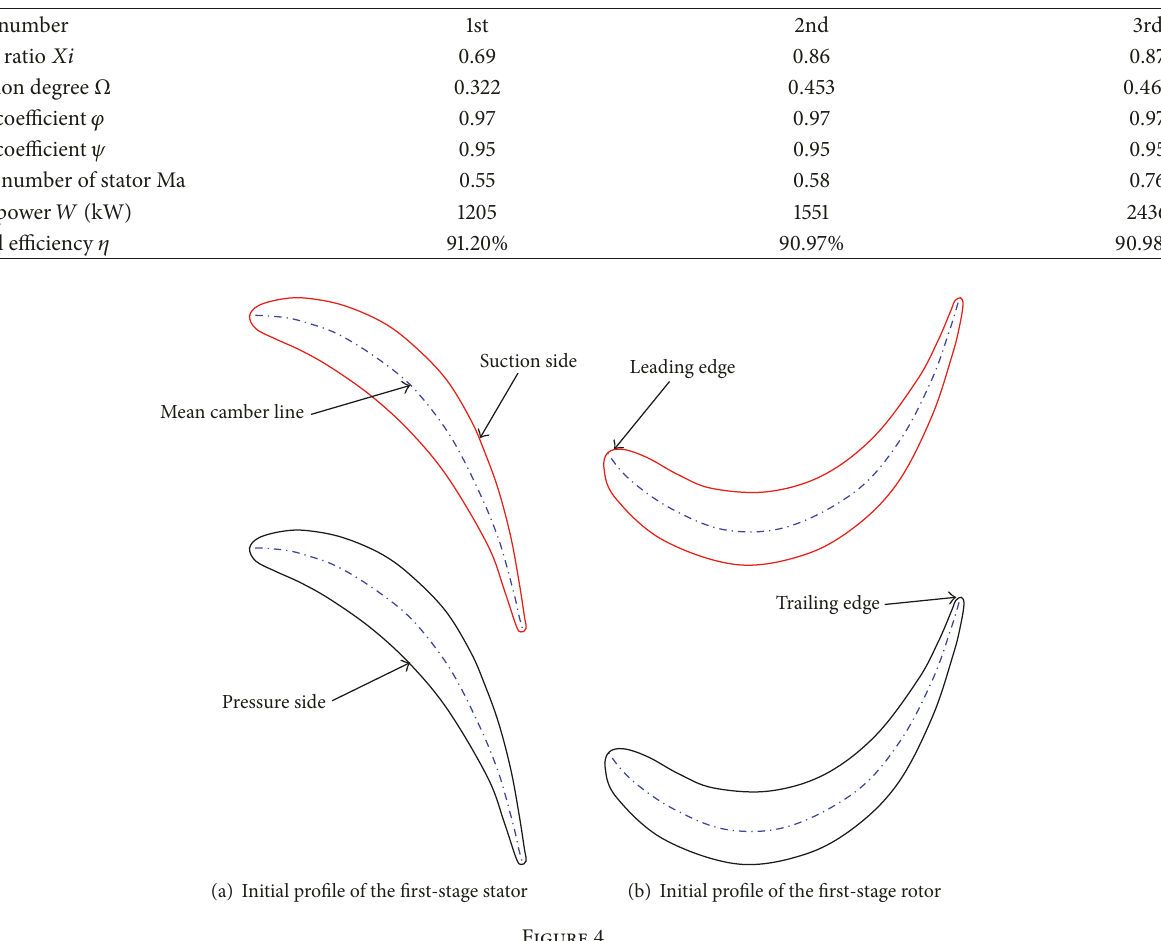
Table 2: The main aerodynamic parameters of each stage.